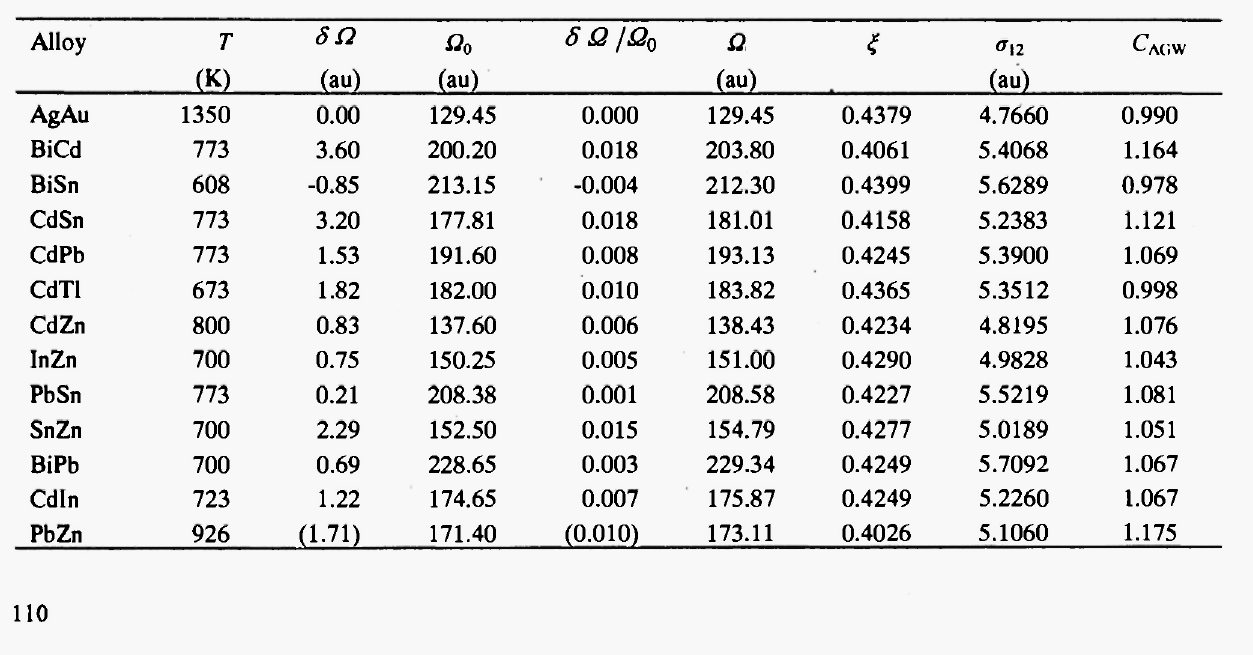
Input data of the present calculation for 13 alloys ( C\ = c 2 = 0.5) with volume change on alloying. Ω = Ωο (1 + δ Ω/Ω 0 ) , where Ω 0 = CyQ + ο 2 Ω 2 with c, and c 2 = 0.5. The values of δ Ω /X?o are taken from the table of Ref./9/. <7 12 (m) = a 1 2 ( a u ) a B